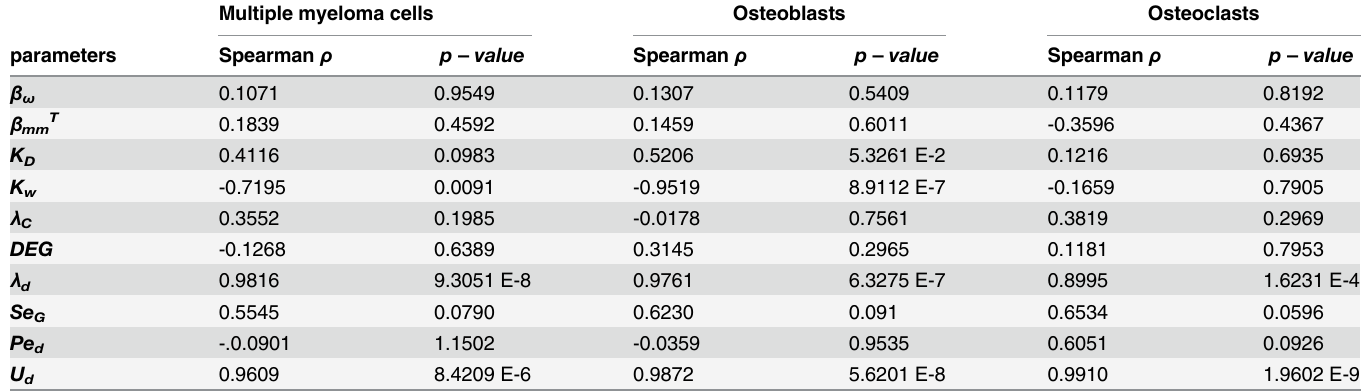
Table 3. Spearman rank-order correlations and p-values for model parameters and simulation outcomes. Multiple myeloma